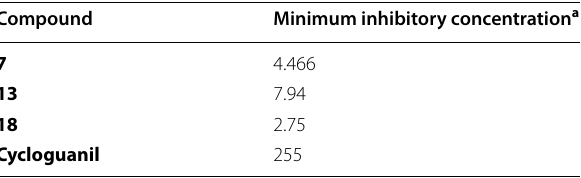
Table 3 Synthesized trisubstituted triazine compounds Compound no.